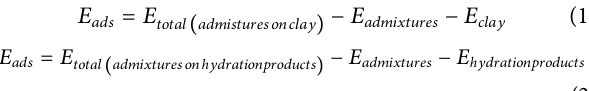
Frontiers in Earth Science |